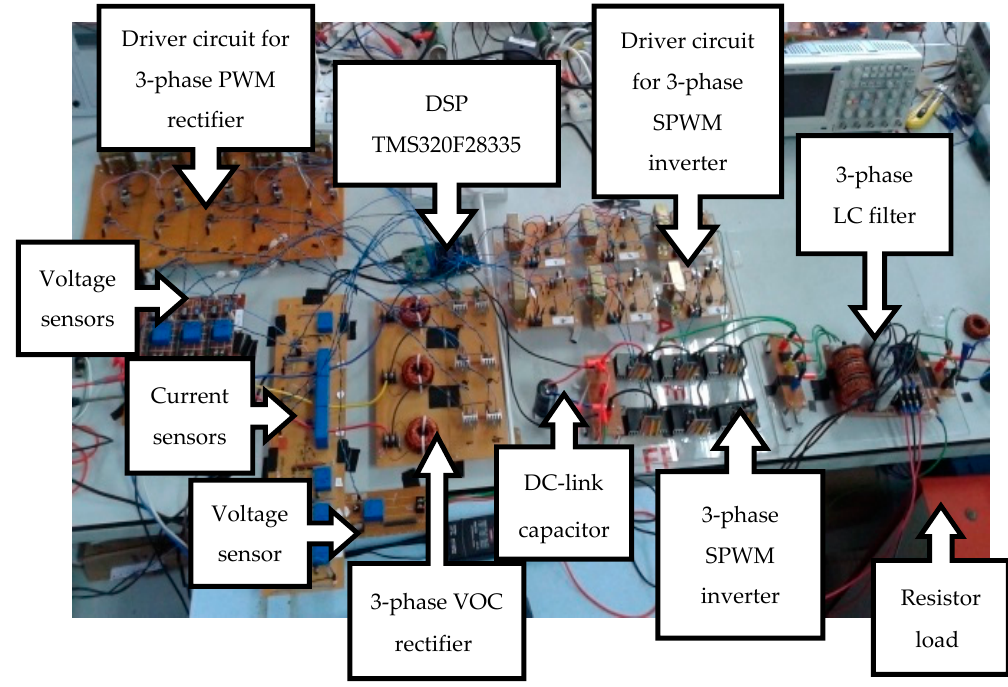
Figure 13. Prototype implementation of EV fast charger.